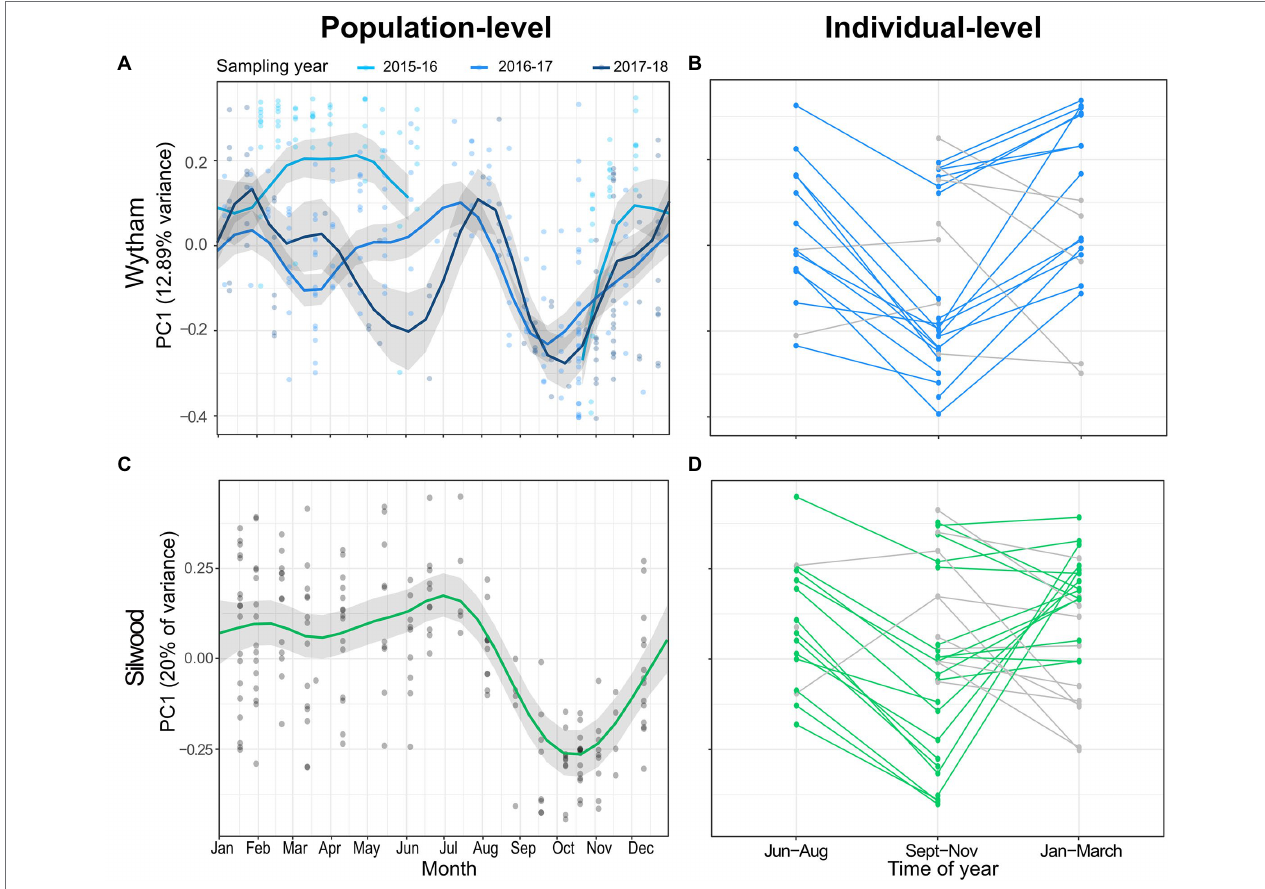
FIGURE 2 | Seasonal restructuring of the wood mouse gut microbiota in two wild populations. (A,C) Seasonal dynamics in population-level PC1 value (the position of samples along the first axis of a principal coordinates analysis on Bray–Curtis dissimilarity) in (A) Wytham and (C) Silwood show compositional change over time. Data from Wytham mice come from a 3-year period (October 2015–2018), while Silwood mice were sampled for 1 year (November 2014–2015). Predicted values and 95% CIs for the smoothed day of the year from generalised additive mixed models (GAMMs) are plotted along with raw PC1 values. (B,D) Changes in PC1 within repeat-sampled individual mice typically track the population-level seasonal shifts in both populations (coloured lines), with some exceptions (grey